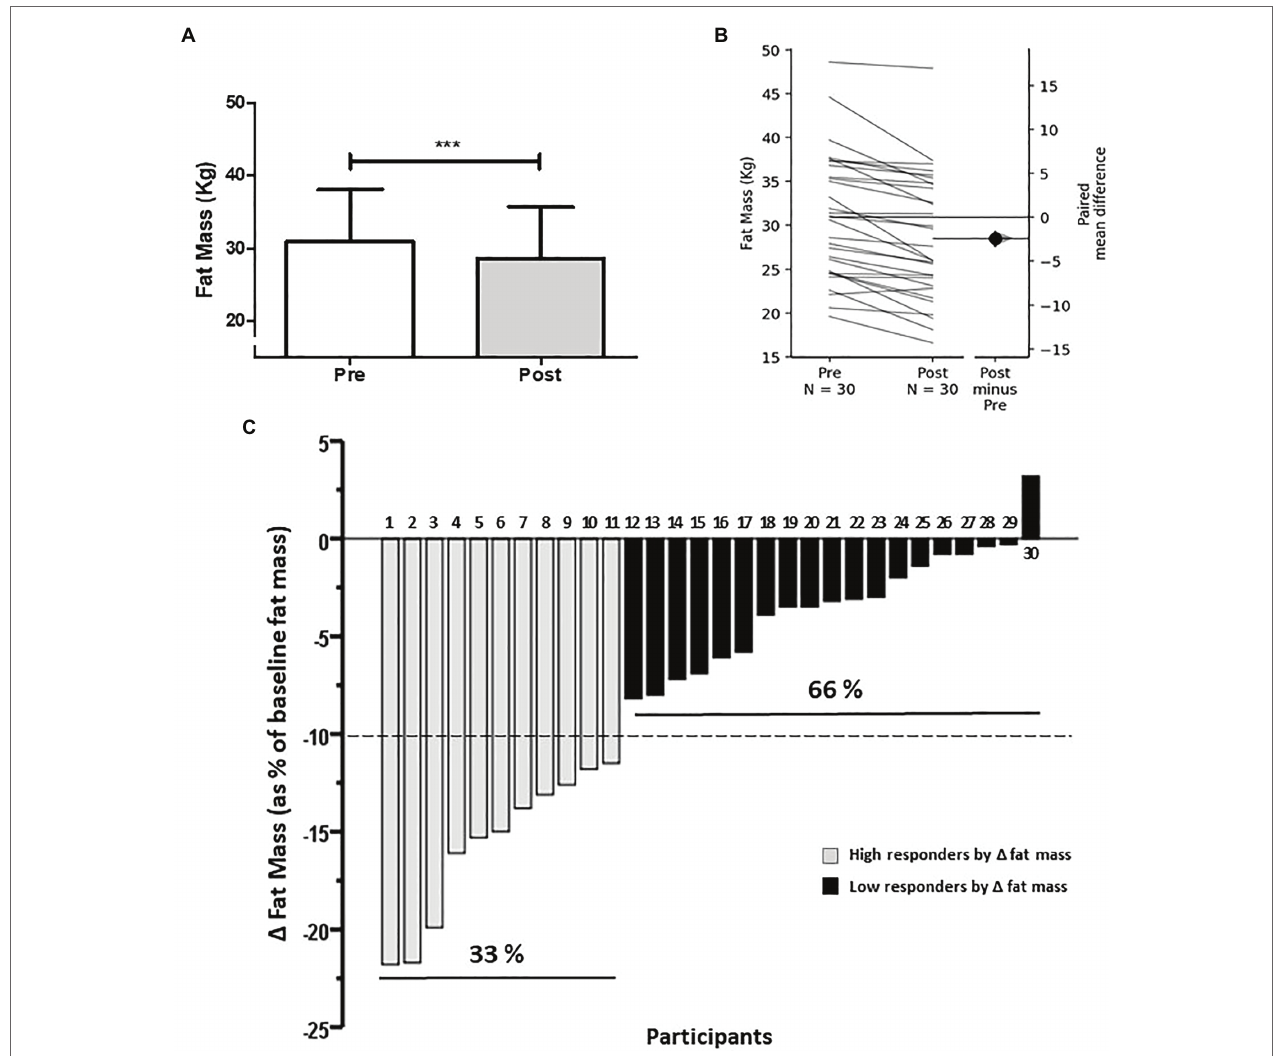
FIGURE 2 | Average changes (A) and individual response (B,C) to decrease absolute fat mass after 12-week intervention ( A : absolute fat mass; B : Gardner Altman Plot with individual responses on the left axes as a line graph and the mean difference between groups on floating axes on the right; and C : individual changes in delta fat mass as % of baseline absolute fat mass). Numbers on the bars in panel (C) represent the order of magnitude in the individual response to reduce fat mass. High and low responders are identified in relation to the ability to reduce fat mass. *** p <